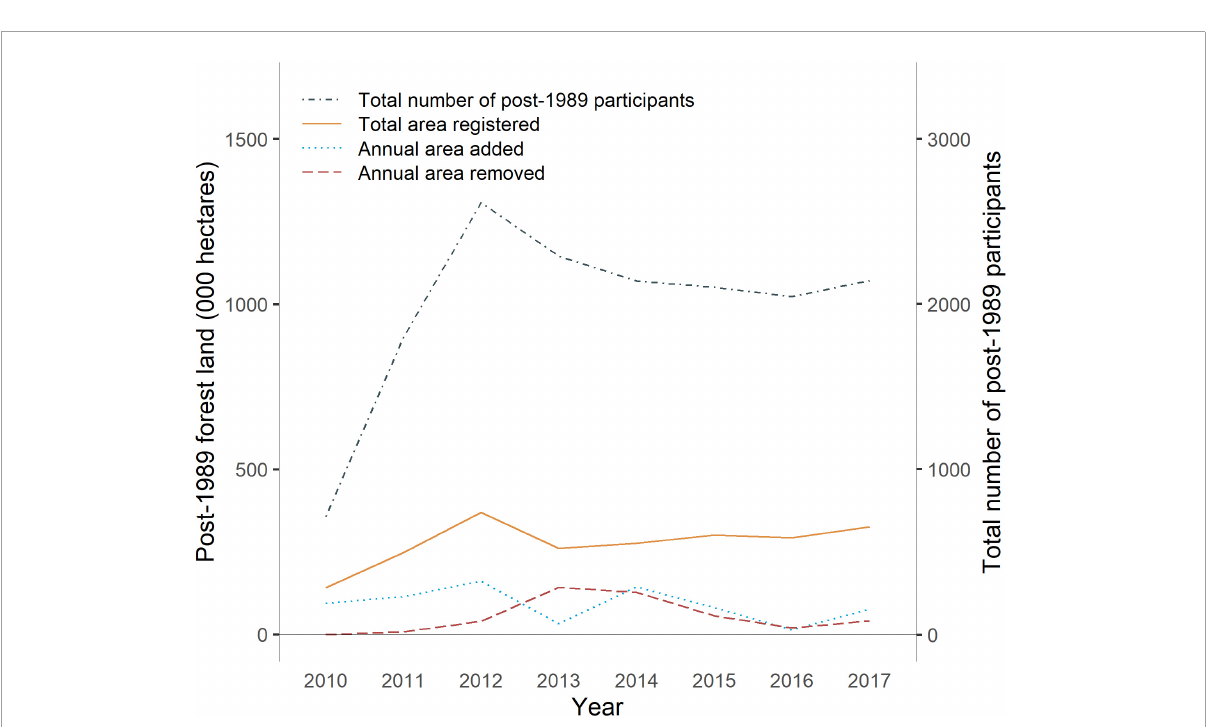
FIGURE4 Area and participants for post-1989 forest land registered in the NZ ETS. Note that all values are based on a calendar year. Data from MPI (2018).